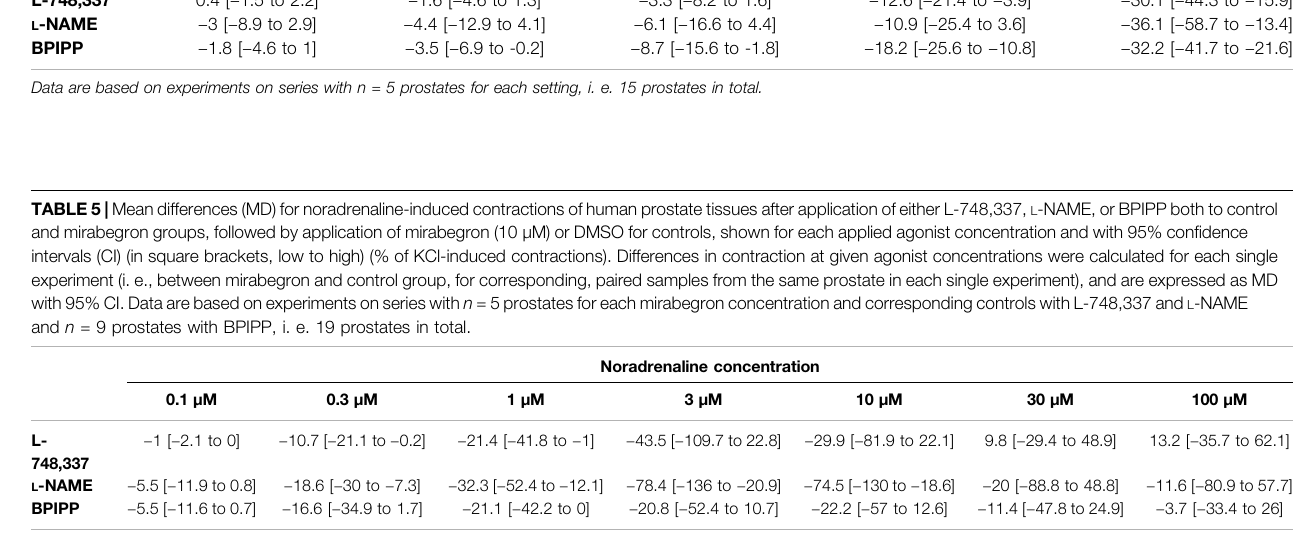
Data are based on experiments on series with n (cid:1) 5 prostates for each setting, i. e. 15 prostates in total.